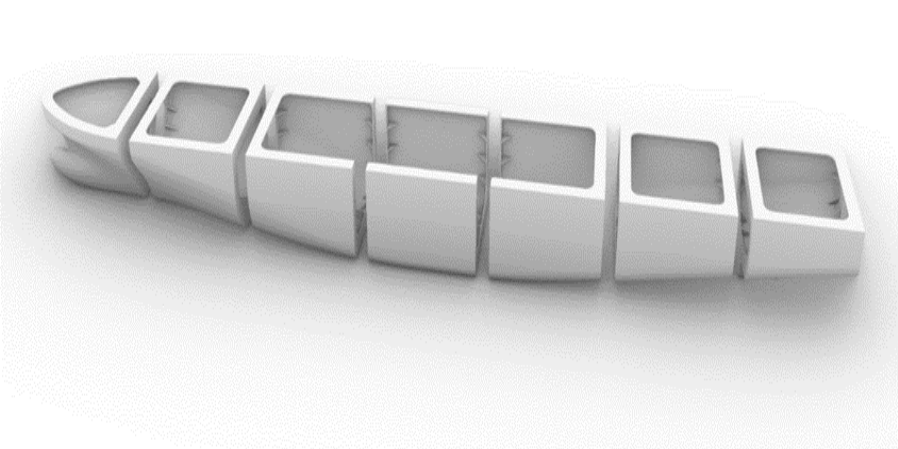
Figure 1. DTC Hull.